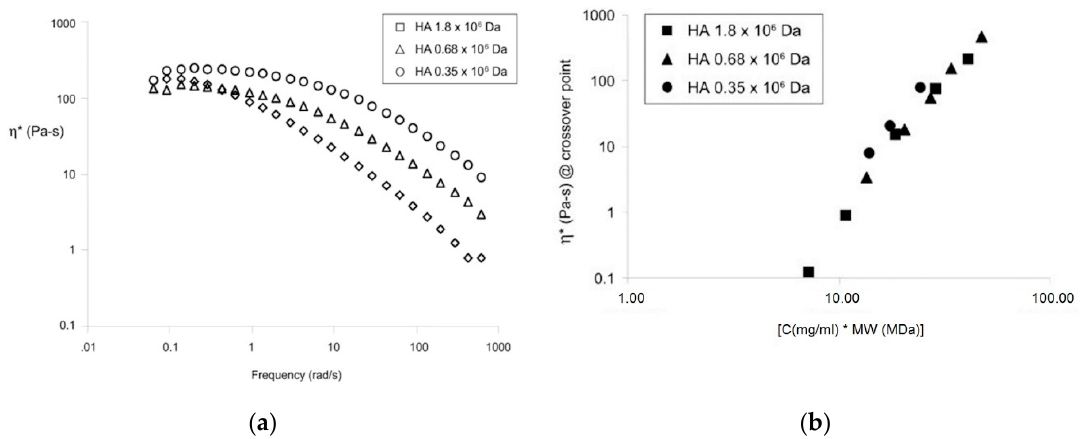
Figure 4. The dependency of the complex viscosity of frequency for hyaluronic acid with various molecular weights ( a ). The dependency of the complex viscosity at the crossover point on the [hyaluronic acid concentration × molecular weight] ( b ). Reproduced from [49], with permission from John Wiley and Sons,